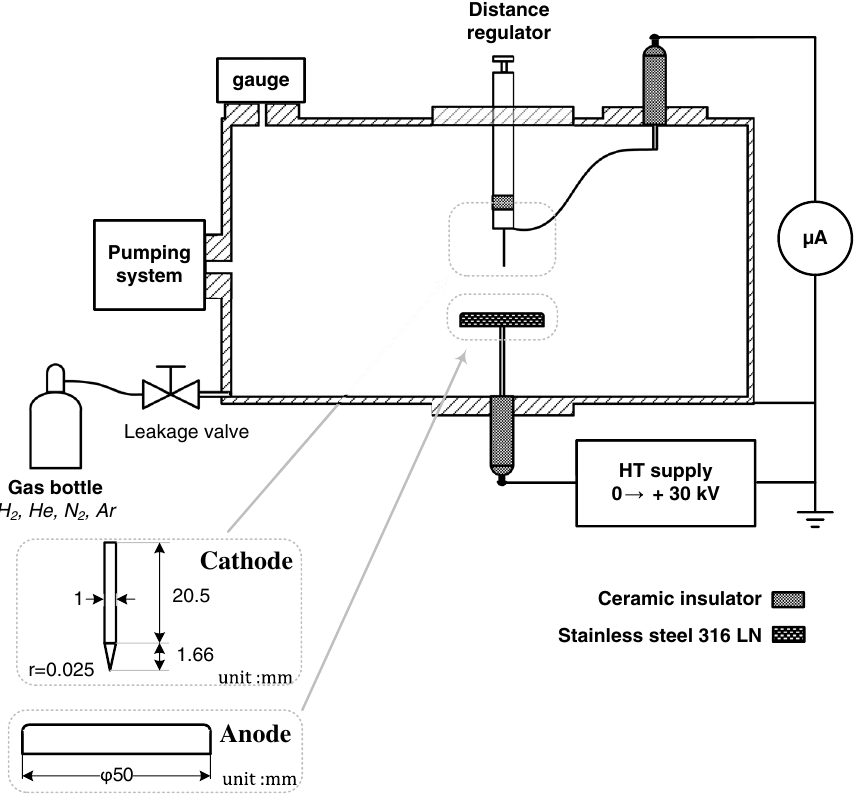
FIG. 1. Schematic view of the experimental apparatus.